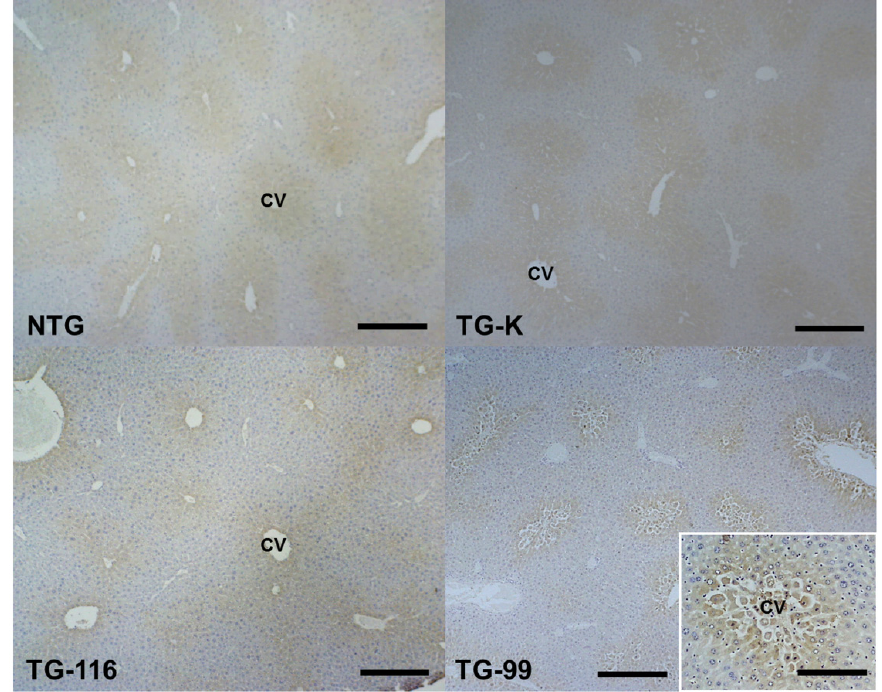
Figure 4. Immunohistochemistry staining of CYP2E1. All groups showed CYP2E1 positive cells in the centrilobular area. More CYP2E1 positive cells were observed in the